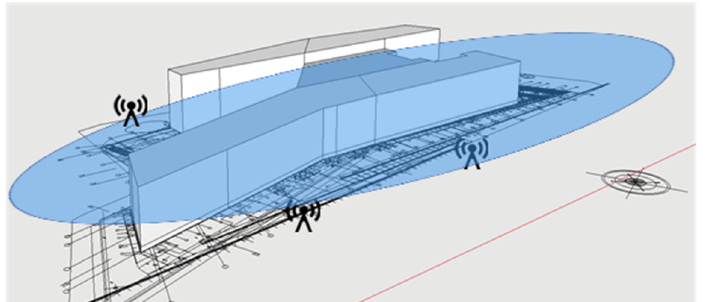
Figure 4. Concept drawing for the outdoor antenna to provide a 5G non-standalone network.